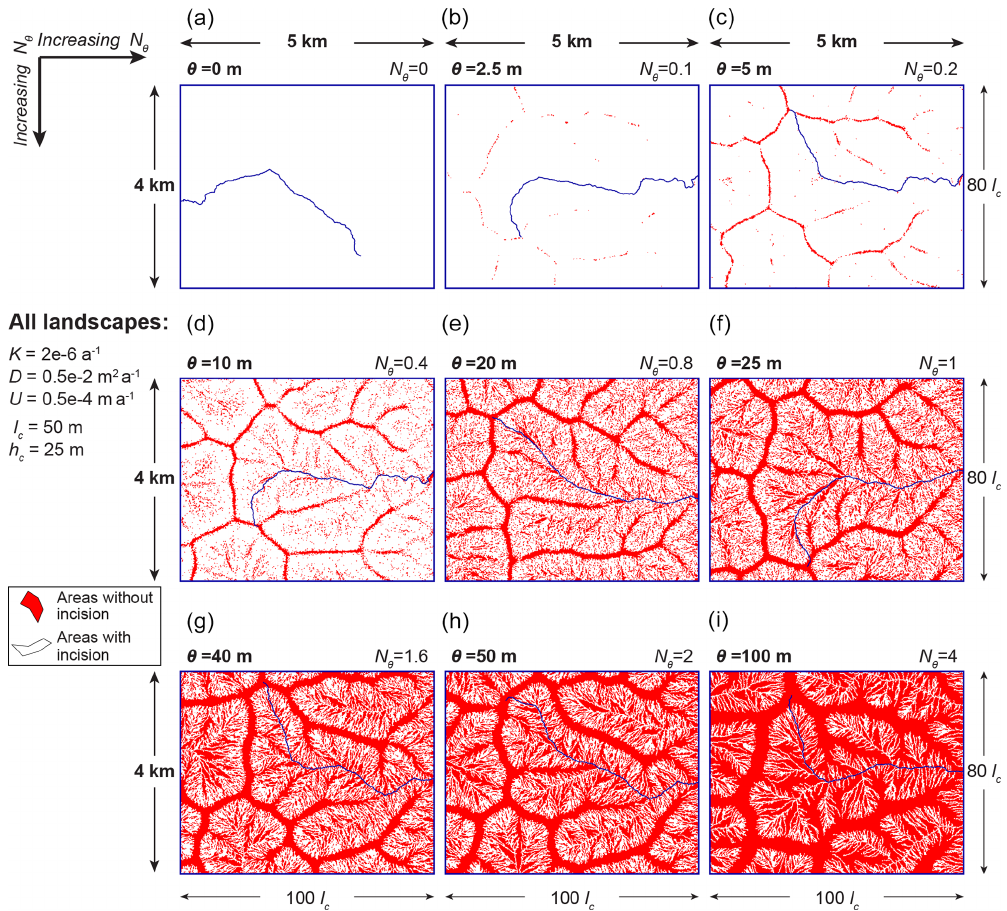
Figure 7. Expanding extent of zones of zero incision as the incision-threshold number N θ increases. Red regions indicate Voronoi polygons √ A |∇ z | ≤ θ , where incision does not operate (Eq. 1), and white indicates the remaining areas where incision operates. Note of points with that the landscape with N θ = 0 follows Eq. (2), which is not defined piecewise; thus, zones of zero incision are not defined for this landscape. As N θ increases, the zones of zero incision become more extensive and eventually occupy almost all ridges and hillslopes. In the maps in (a) – (c) , which have the smallest of the examined N θ values, zero-incision zones appear mainly along divides of major drainage basins. In the maps in (d) – (f) , which have moderate N θ values that do not exceed 1, zero-incision zones completely cover the main drainage divides and increasingly appear on smaller divides (interfluves) and on hillslopes. In (g) and (h) , which have N θ equal to 1.6 and 2, zero-incision zones occupy increasingly large portions of hillslopes, and in (i) , which has N θ = 4, they almost completely cover the hillslopes, with the white areas following the dendritic patterns of the valley network, which can be seen also in Fig. 8. Thus, for the largest of the examined N θ values, incision operates almost exclusively in valleys and is largely non-existent on the